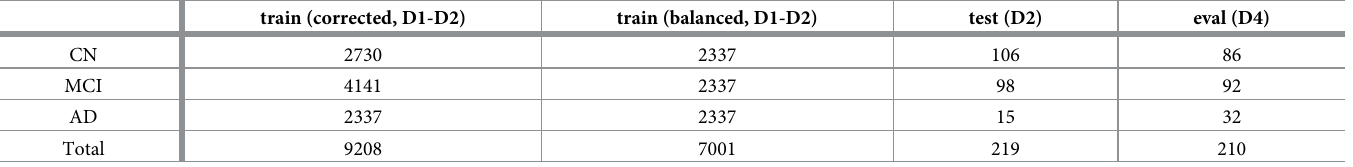
Table 1. Number of cognitive normal (CN), mild cognitive impairment (MCI), and Alzheimer 0 s disease (AD) individuals in the training, test, and evaluation sets used in this work. train (corrected, D1-D2) train (balanced, D1-D2) test (D2) eval (D4) CN 2730